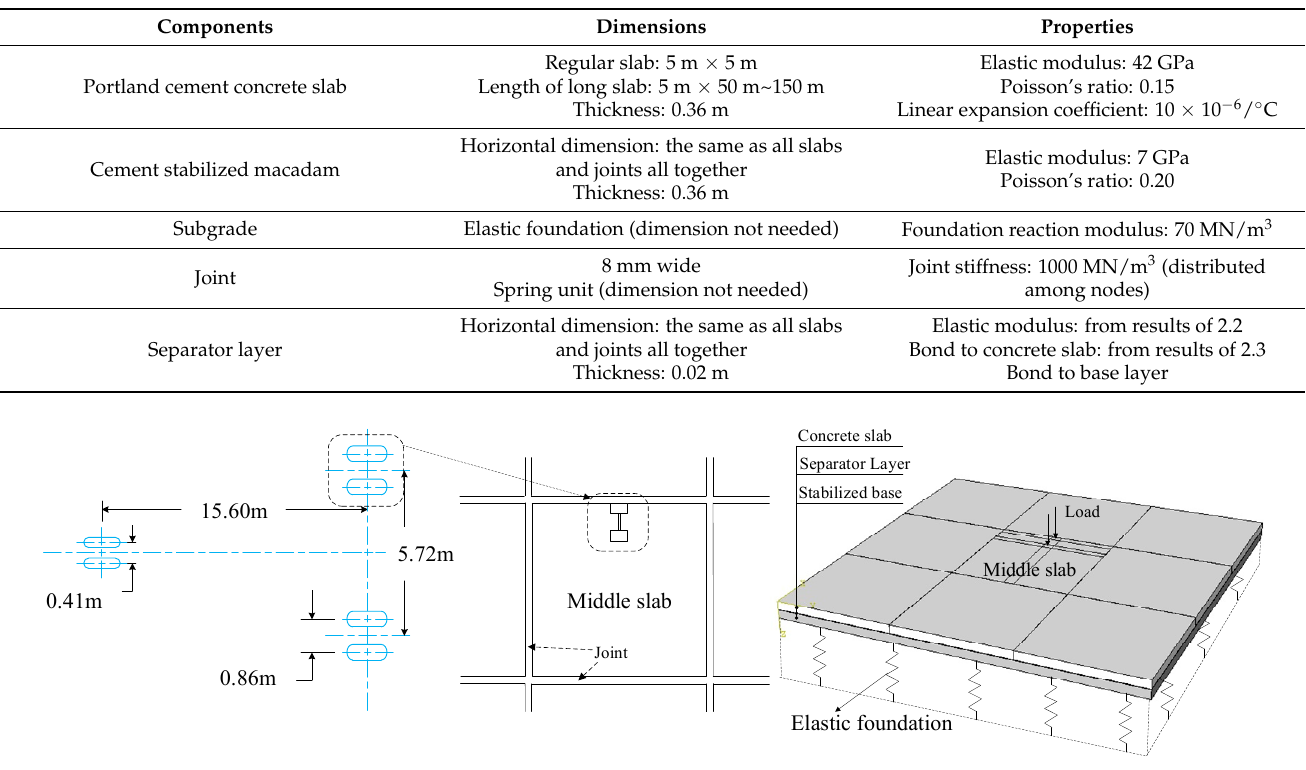
Figure 7. Loading of B737-800 airplane wheels and FEM pavement structure (second model).